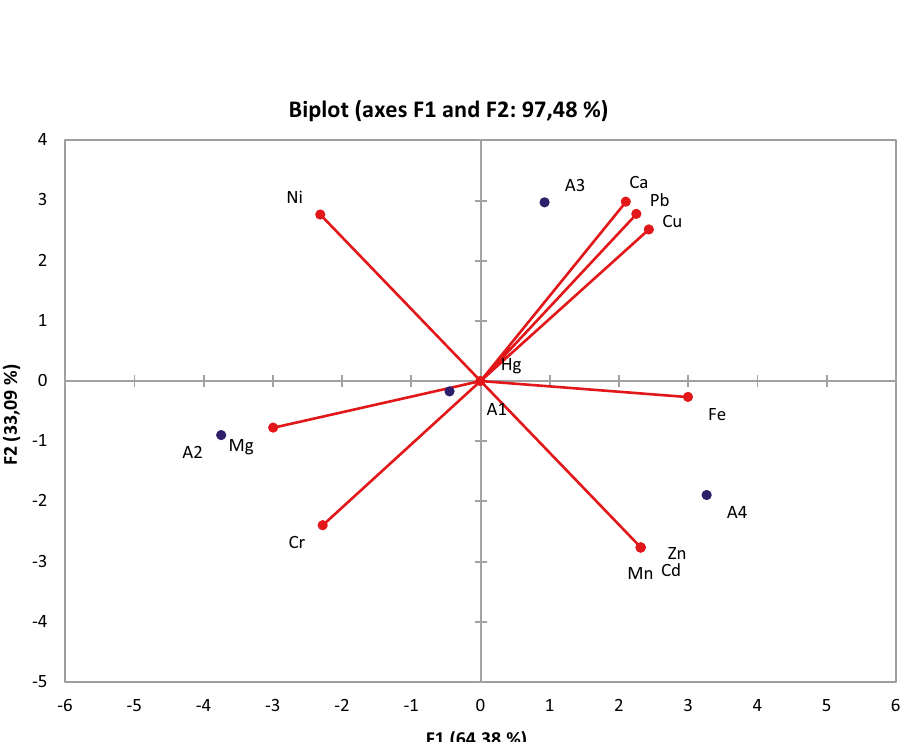
Biplot (axes F1 and F2: 97,48